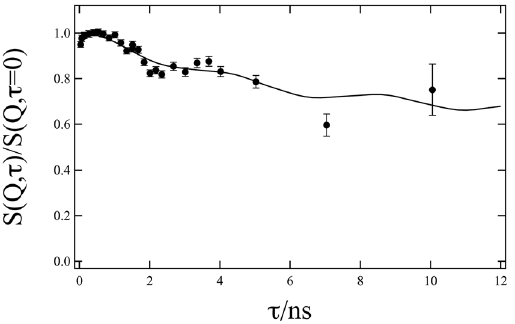
Figure 1. GINSES data of SoyPC membranes in aqueous solution at Q || = 6.7 × 10 − 3 Å − 1 . The solid line is a fit with the model from Romanov et al . as described in the text with B = 3.4 × 10 6 Pa and η = . 0 0075